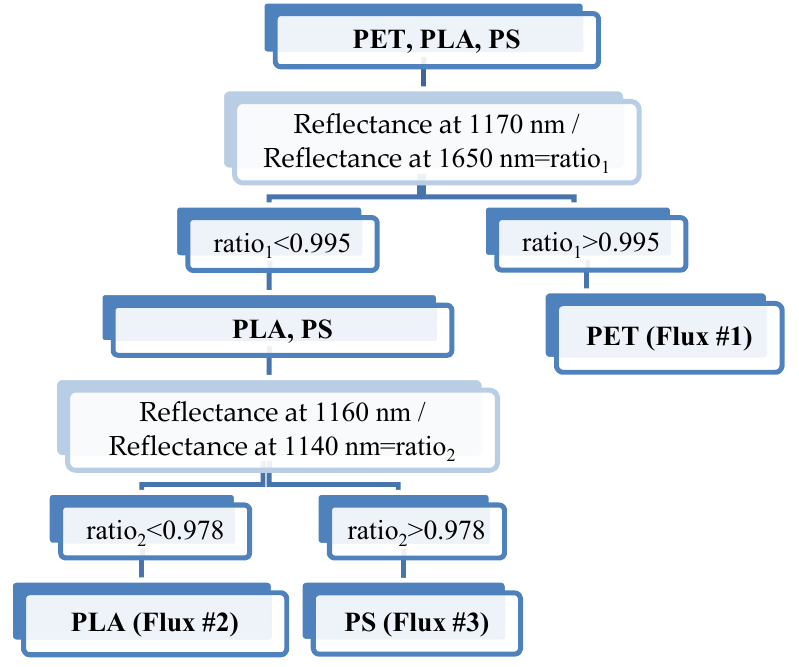
Figure 11. Separation sketch employing the ‘tree procedure’ used to separate PET, PS and PLA.